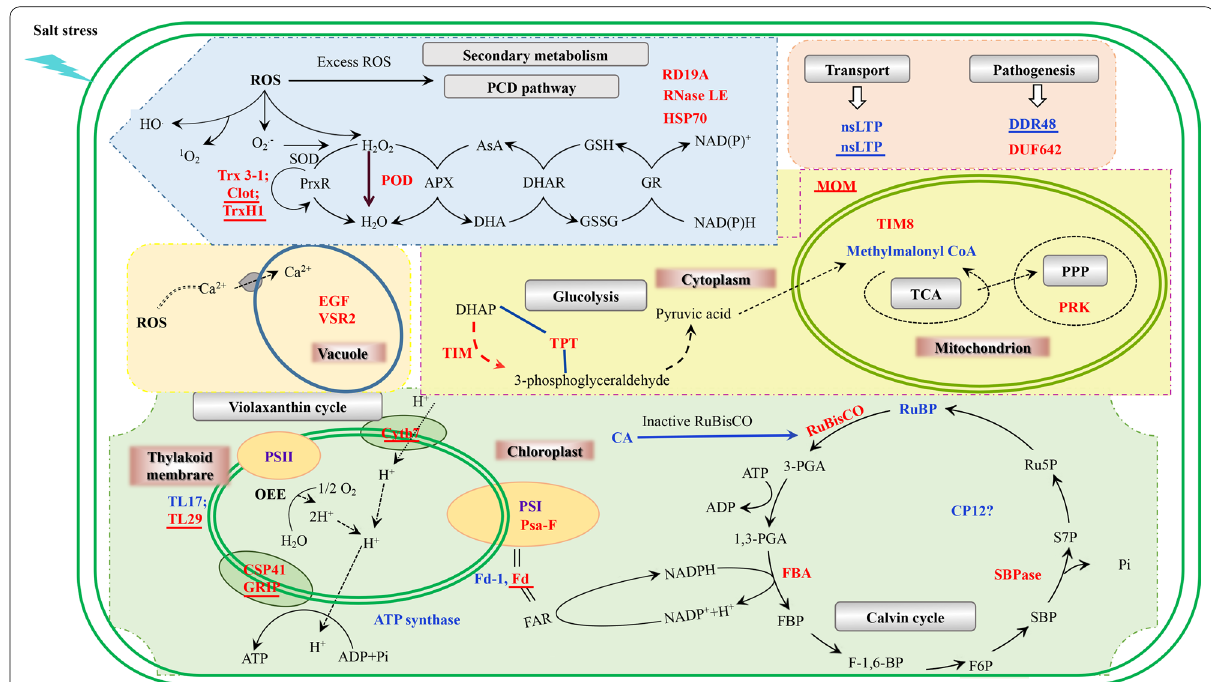
Fig.5 Schematic presentation of systematic salt tolerance mechanisms in BvM14 leaves. The identified proteins and redox-responsive proteins were put into subcellular locations and KEGG pathways. The red and blue colors indicate increased and decreased in redox PTMs, respectively, and those underlined red and blue highlight proteins with increased and decreased levels, respectively. Please refer to Additional file 8: Table S6 for protein